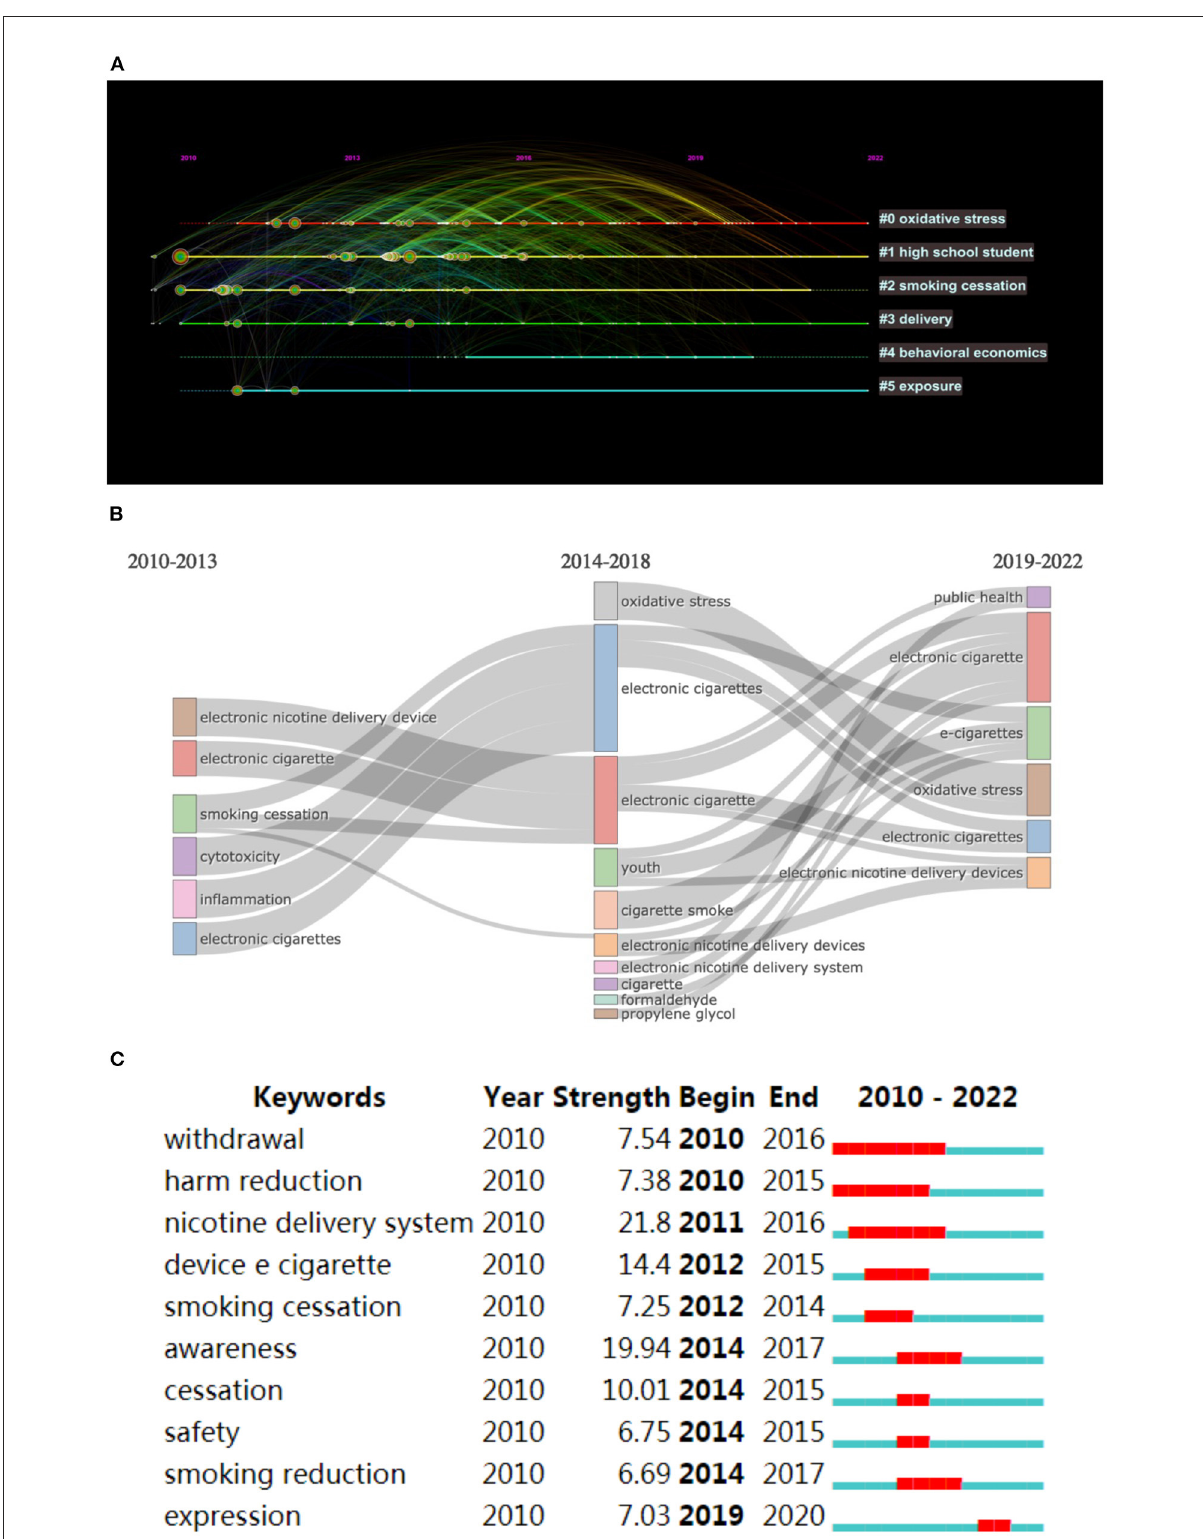
FIGURE6 Visual analysis of keywords. (A) timeline analysis after keyword clustering; (B) keyword Sankey evolution diagram of e-cigarette research; (C) representative burst keywords in the top 10